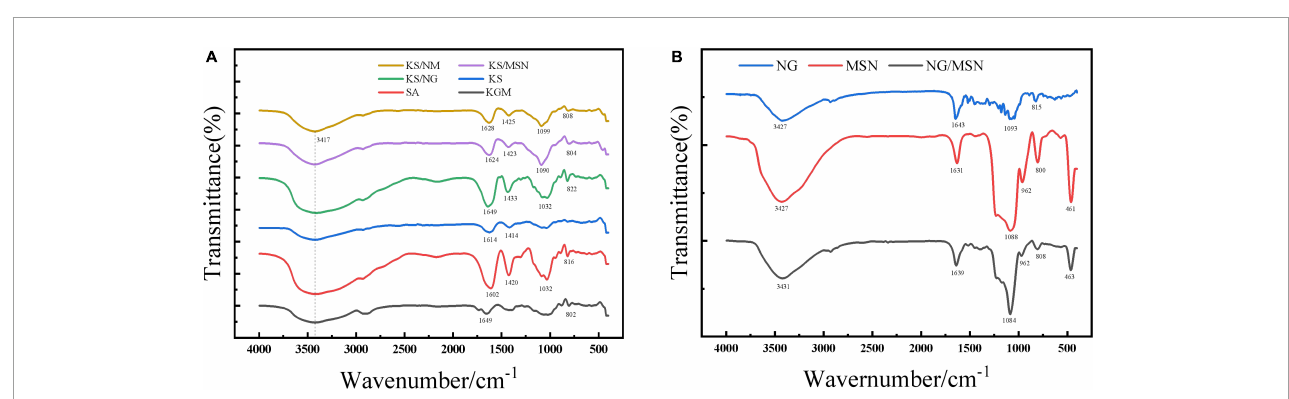
FIGURE6 Infrared spectra of KGM, SA, KGM/SA, KS/NG, KS/MSN, KS/NM (A) and NG, MSN, NG/MSN (B)